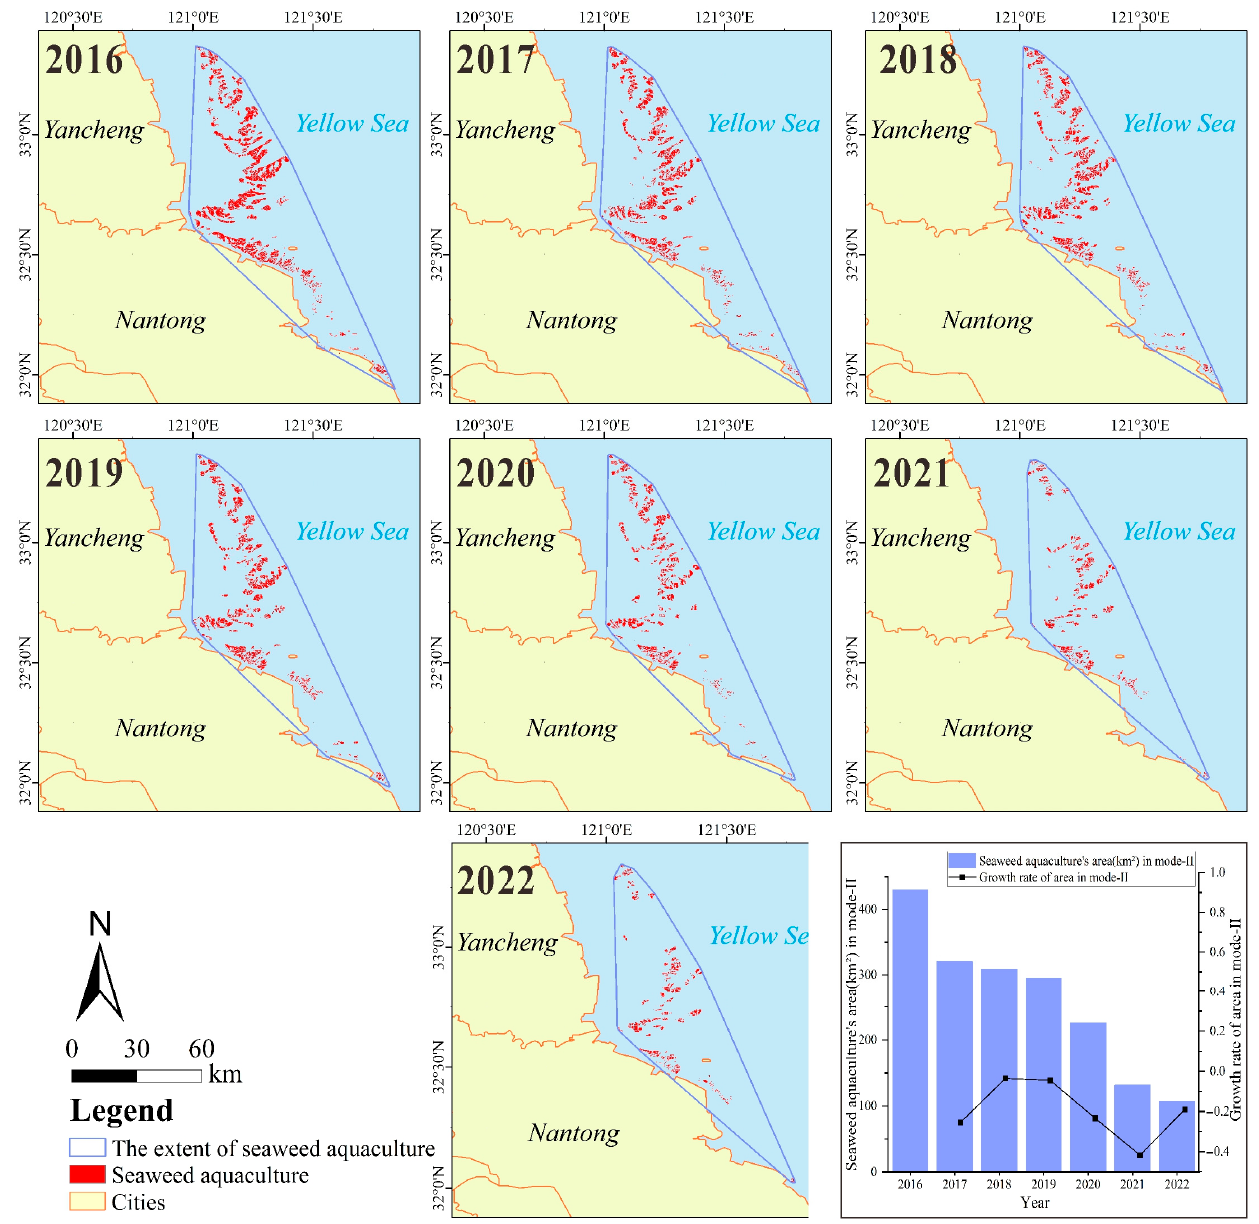
Figure 6. Spatiotemporal dynamics of seaweed aquaculture in mode-II (2016–2022).